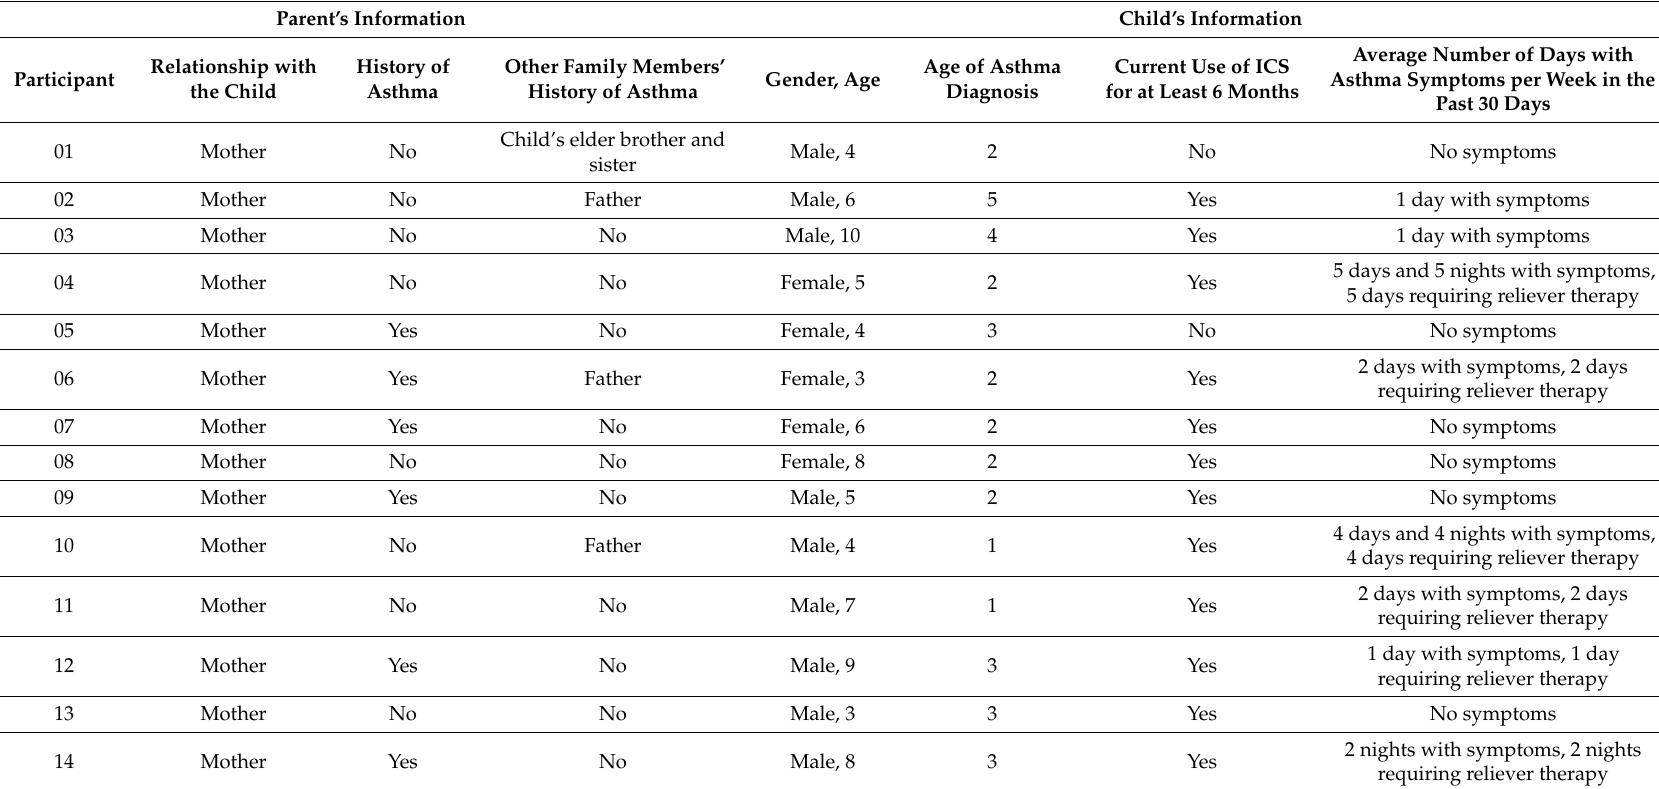
Table 1. Characteristics of the interviewed parents and their